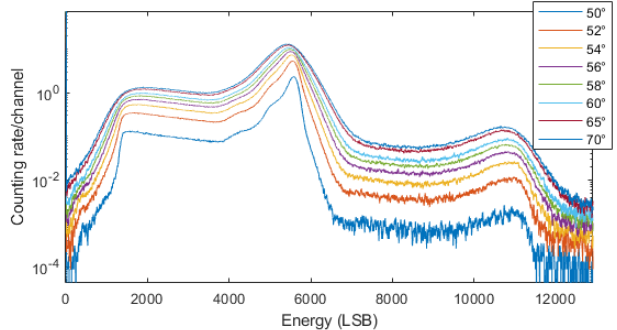
Fig. 5. Energy distributions of pulses in channel 0 (inner ring detector) for various shutter angles. Increasing the counting rate changes the shape of the energy spectrum: the peak becomes larger and slightly shifts towards low energies. T ABLE II PSD F ILTERING PARAMETERS FOR 3H E PROPORTIONAL COUNTERS